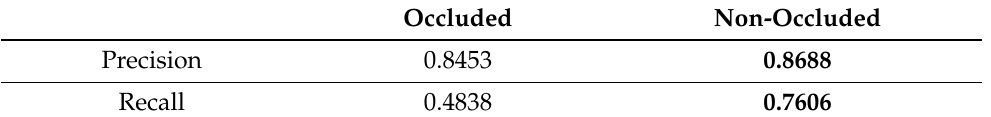
Table 2. Metrics for room segmentation.